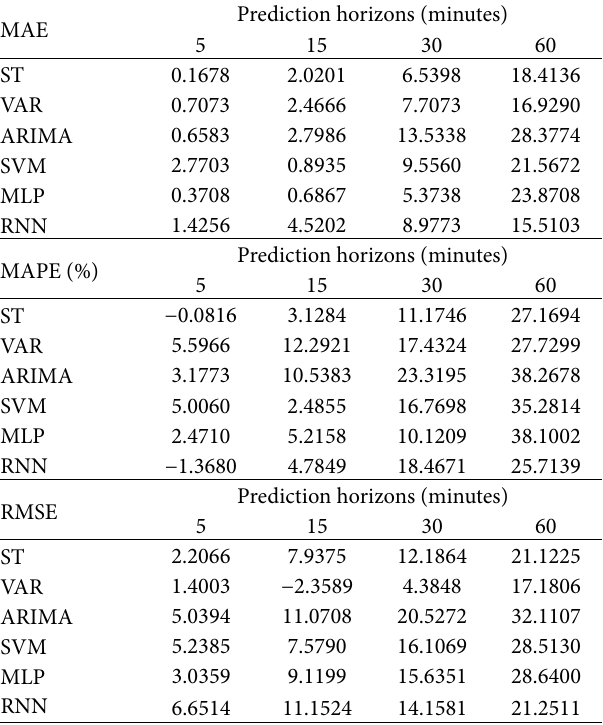
Table 1: Improvement percentage of hybrid models for different prediction horizons in peak hours at station C (time scale: 5 min).